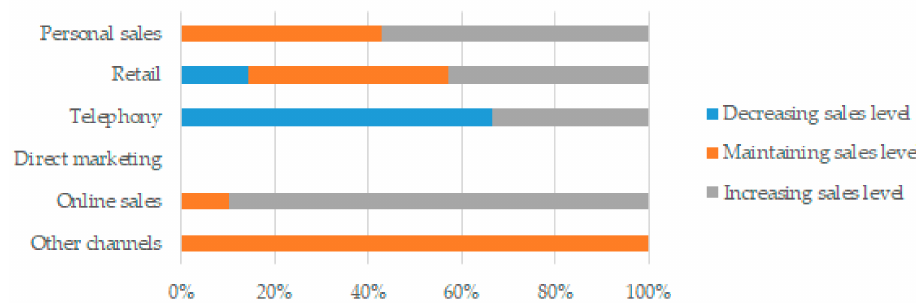
Figure 4. Sales trends by individual sales channels.